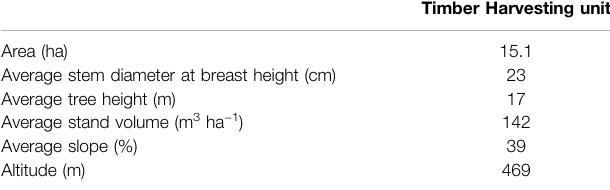
TABLE 1 | Stand characteristics of the study area.